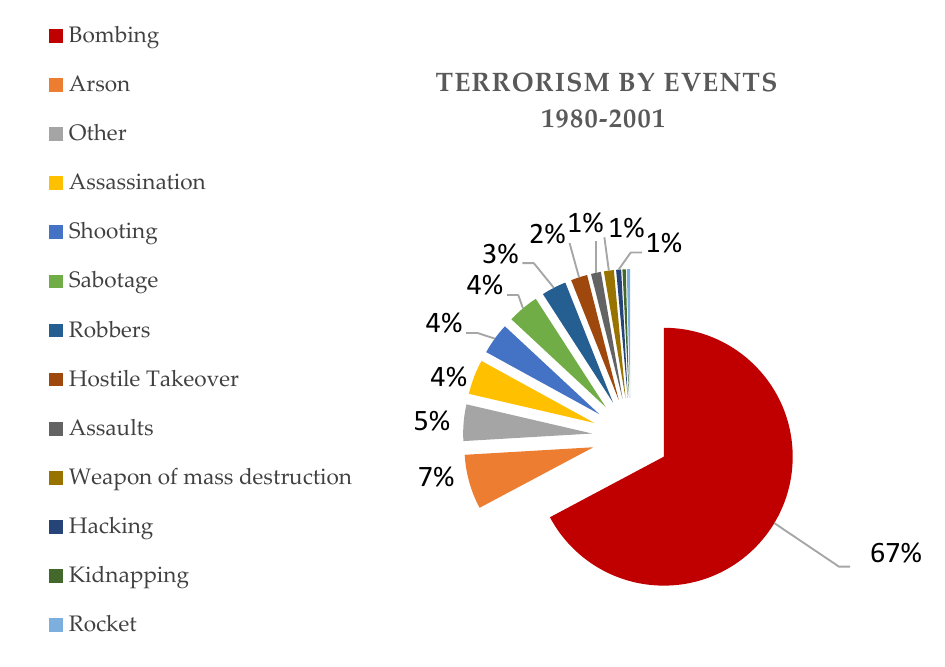
Figure 6. Terrorist incidents by event 1980–2001-Source US-FBI.